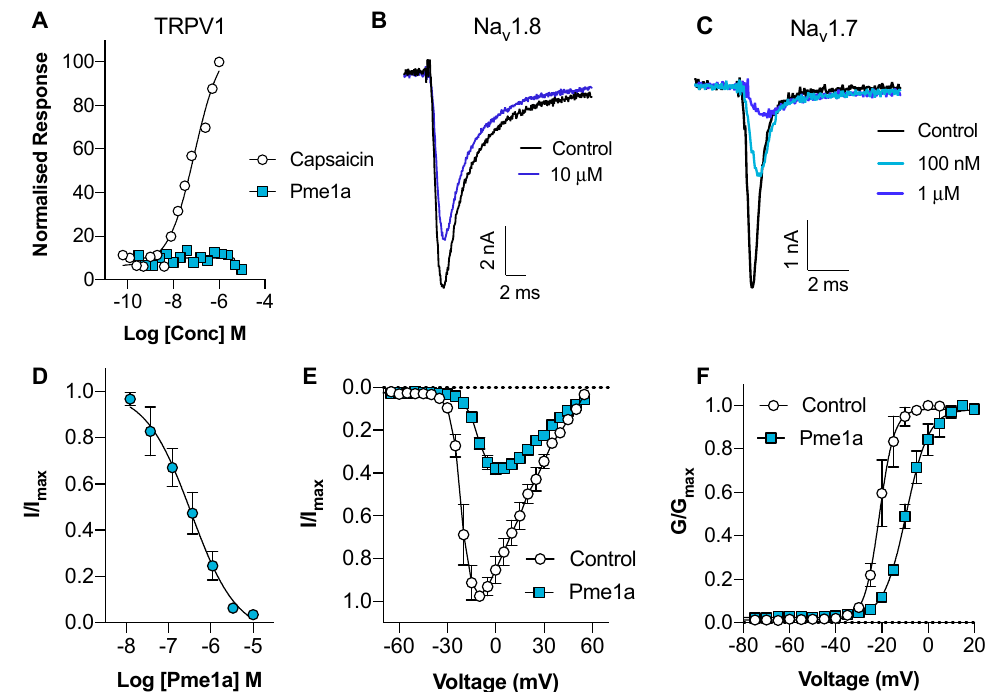
Figure 3. Activity of synthetic Pme1a on TRPV1, Na V 1.8 and Na V 1.7. ( A ) Concentration–response curves for capsaicin and Pme1a at rTRPV1 assessed by calcium dye. Data are presented as the mean ± SEM, with n = 3–5 wells per data point. ( B ) Representative hNa V 1.8 current trace before (black) and after addition of Pme1a (blue). Currents were elicited by a 50 ms pulse to + 10 mV from a holding potential of − 90 mV. ( C ) Representative hNa V 1.7 current trace before (black) and after addition of Pme1a (blue). Currents were elicited by a 50 ms pulse to − 20 mV from a holding potential of − 90 mV. ( D ) Concentration–response curve for Pme1a at hNa V 1.7 (IC 50 334 ± 114 nM). ( E ) Current-voltage relationship before (white circles) and after addition of 1 µ M Pme1a (blue squares). ( F ) Conductance-voltage curve before (white circles) and after addition of 1 µ M Pme1a (blue squares). Pme1a shifted the V 1/2 of voltage dependence of activation by +11.6 mV. Data are presented as the mean ± SEM, with n = 3–6 cells per data point.